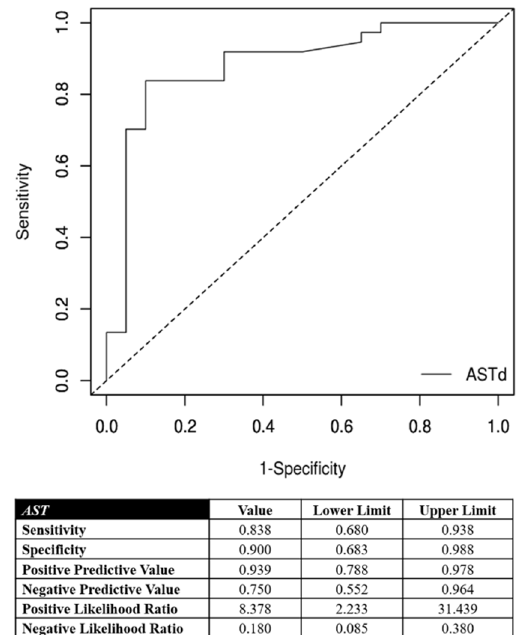
Figure 2. Correlation between aspartate aminotransferase (AST) increase and the objective response for target nodules. In the lower portion of the figure, the performance measures are reported using the optimal cutoff point (46%).